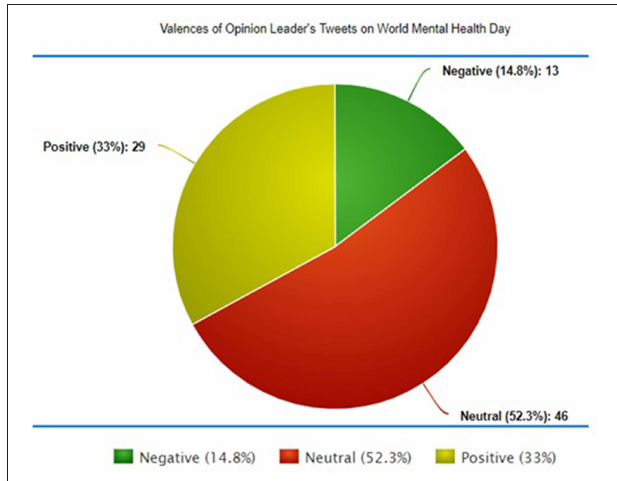
FIGURE 1 | Valences of Opinion Leader’s Tweets on World Mental Health Day.